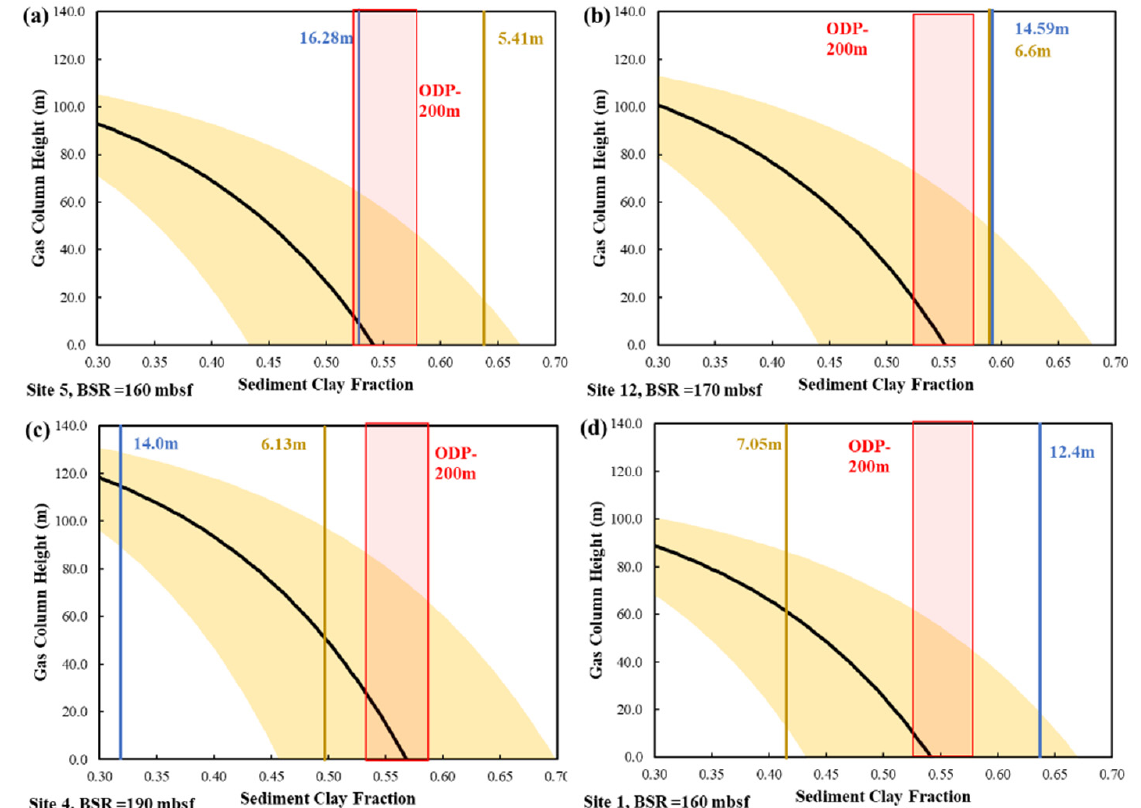
Figure 9. The gas column height required to open fractures for the 4 sites for varying sediment clay fraction ( f c ). The sites are shown from west to east. Site 5 ( a ) is the westernmost, followed by Site 12 ( b ), Site 4 ( c ) and Site 1 ( d ). The red shaded region shows the likely sediment clay fractions ( f c = 0.53–0.57) at the BSR obtained from the ODP data (Figure 7b) named ODP-200m. The sediment clay fraction obtained from the calypso cores (Figure 2c) as mentioned in Table 1 are shown by the blue and dark yellow lines. The black curves show the median prediction of gas column height required to open fractures and the shaded region is the uncertainty ( ± 1 SD).